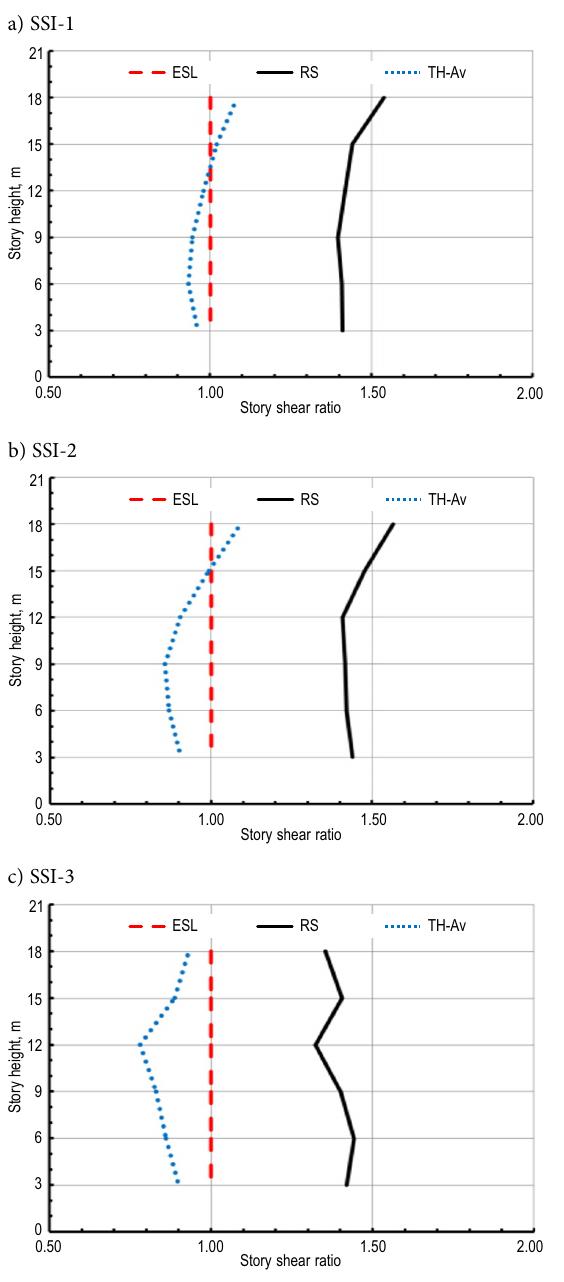
Fig. 13. Story shear force response of SSI model to that of NSSI modelof 6-story models